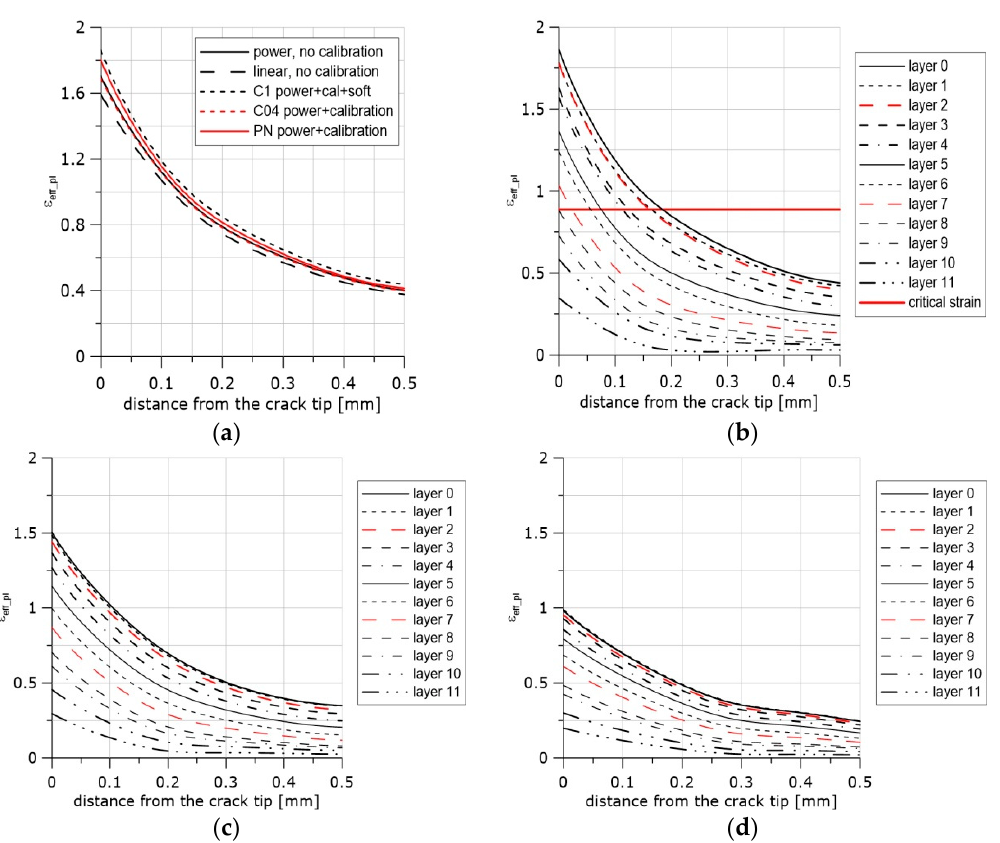
Figure 11. Distributions of the effective plastic strain along the crack front. ( a ) Curves recorded at the final moment of loading after calibration using specimen R1 and the material softening option, material N, temperature +20 °C. ( b ) Curves recorded at the final moment of loading after calibration using specimen R1 and the material softening option, material N, temperature +20 °C. Strain distributions are presented for all layers through the specimen thickness. ( c ) Curves recorded at the 25th/30th step of loading after calibration using specimen R1 and the material softening option, material N, temperature +20 °C. ( d ) Curves recorded at the 20th/30th step of loading after calibration using R1 specimen and the material softening option, material N, temperature +20 °C.